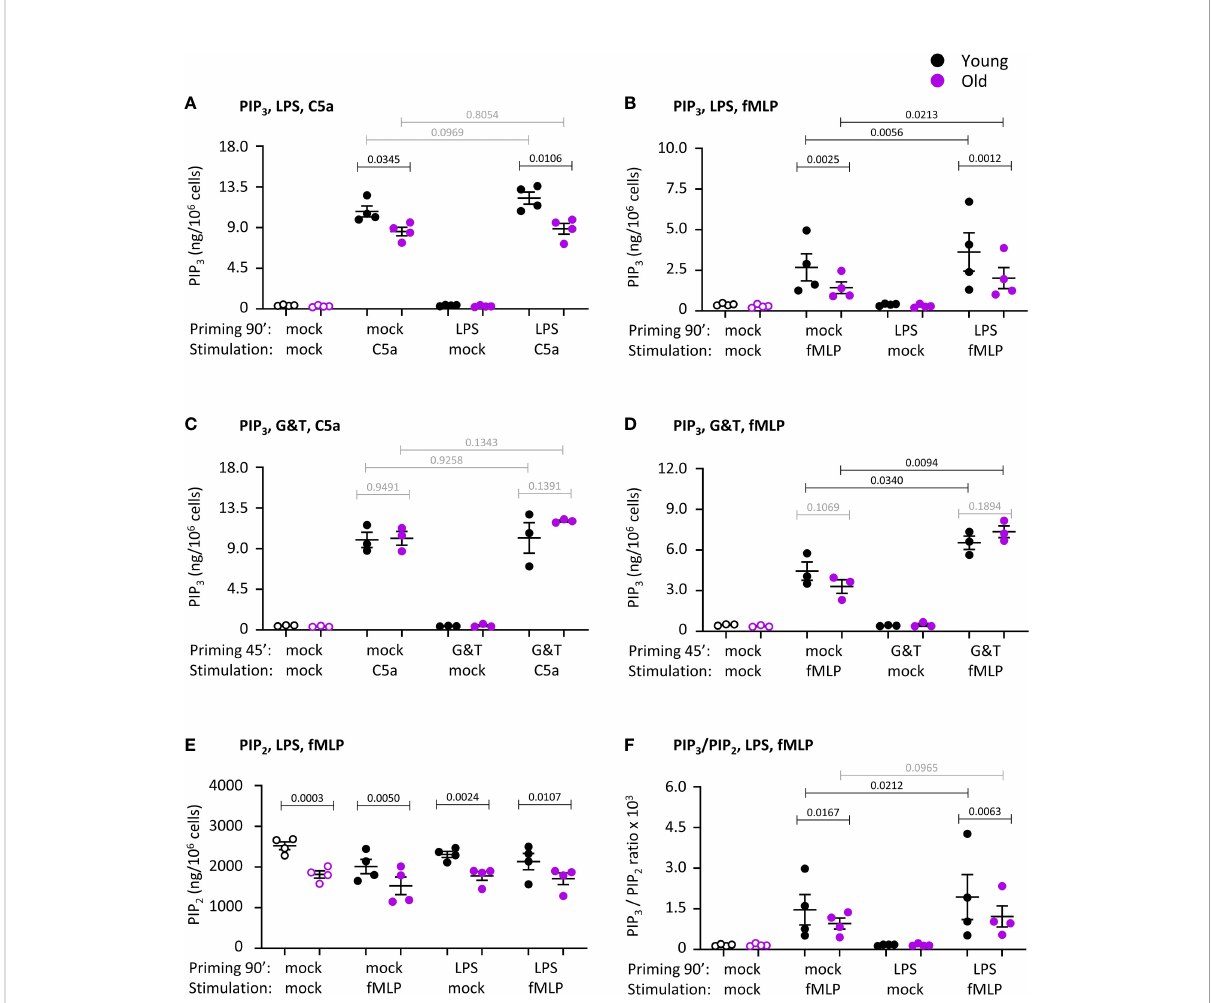
FIGURE 9 Hornigold K et al. PIP 3 production and PIP 2 levels are reduced in neutrophils from old mice. Neutrophils from young (8-10 weeks, black symbols) and old (24 months, purple symbols) mice were primed with 1 m g/ml LPS or mock-primed for 90 min (A, B, E, F) , or were primed with 50 ng/ml GM-CSF and 20 ng/ml murine TNF a or mock-primed for 45 min (C, D) , prior to stimulation with 25 nM C5a (A, C) or 3 µM fMLP (B,D- F) , or mock-stimulation, for 10 s. PIP 3 (A-D) and PIP 2 (E) were extracted and quantitated by lipid mass spectrometry using internal